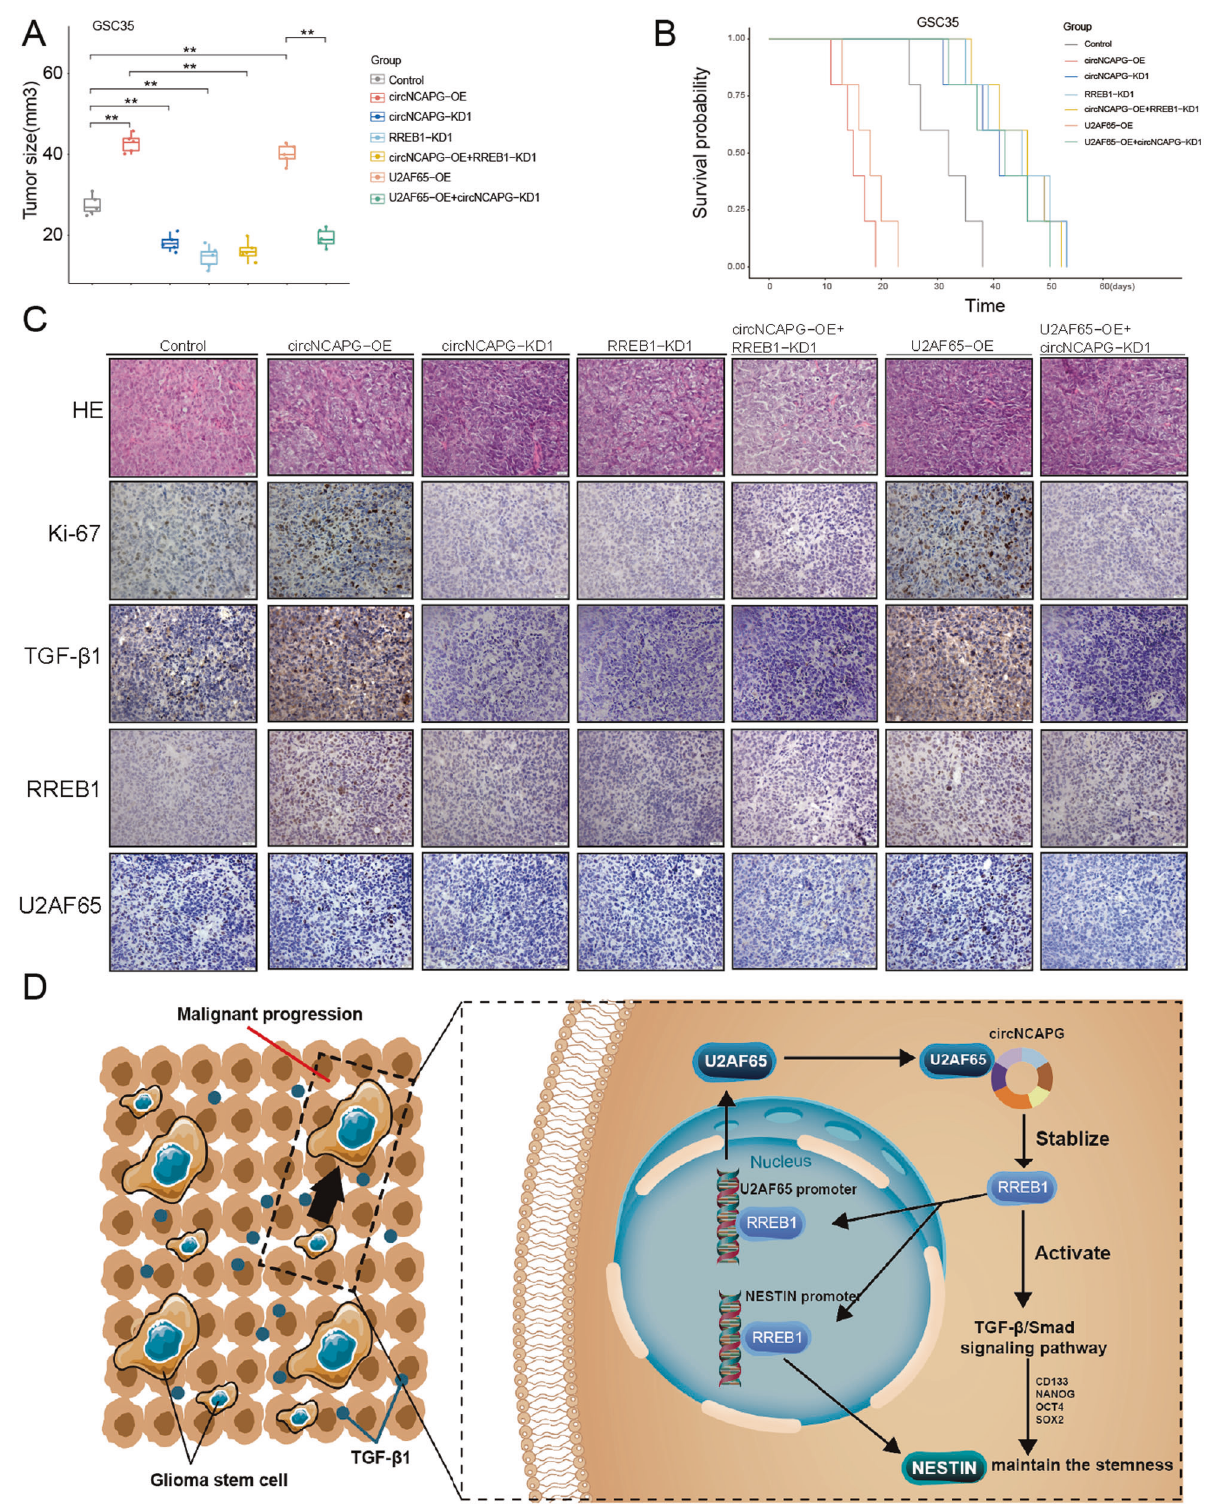
Fig. 8 The U2AF65/circNCAPG/RREB1 feedback loop can regulate glioma tumorigenesis in vivo. A The tumor size of nude mice with control, circNCAP-OE, circNCAPG-KD1, RREB1-KD1, circNCAPG-OE combined with RREB-KD1, U2AF65-OE and U2AF65-OE combined with circNCAPG-KD1 groups. B The Kaplan – Meier survival curves in different mice groups. C Representative immunohistochemical staining showing the changes in Ki67, TGF- β 1, RREB1 and U2AF65, and HE staining in different mice groups. D The schematic of the mechanisms of the U2AF65/circNCAPG/RREB1 feedback loop promotes glioma tumorigenesis via activating the TFG- β 1 signaling pathway. All results are presented as the mean ± SD (three independent experiments). * p < 0.05; ** p < 0.01; *** p < 0.001.